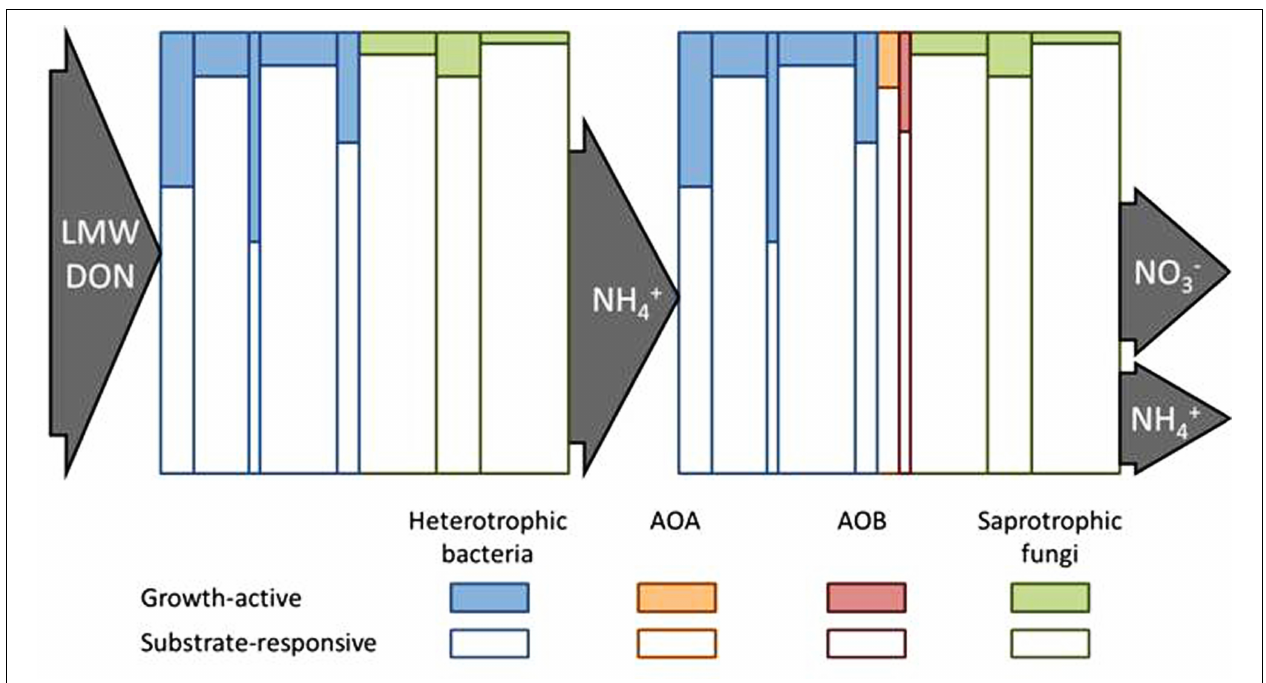
FIGURE 2 | Conceptual diagram to illustrate how the fate of soil N pools might be controlled by the growth-active fraction (GAF) of the substrate-responsive population (SRP) of microorganisms. The heights of the individual vertical columns represent the SRP of different taxa and their widths represent the relative sizes of each taxa as part of the whole microbial community.The shaded portion of each column represents the GAF of each SRP taxon.The left side depicts that low molecular weight (LMW) dissolved organic N (DON) is taken up and metabolized by the SRP but N is only assimilated by the GAF.The balance between NH + 4 mineralized versus N